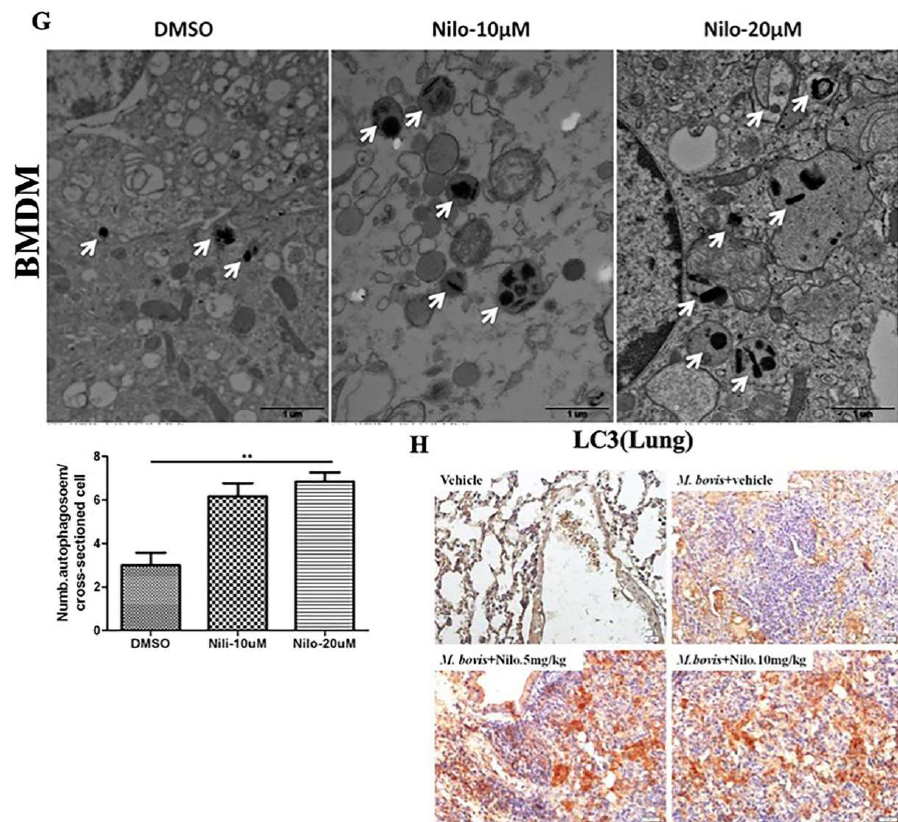
Figure 2. Nilotinib induces autophagy during M. bovis infection. ( A ) and ( B ) BMDM and RAW264.7 cells were pretreated with DMSO (0.1%) or nilotinib 10 µM and 20 µM, followed by M. bovis infection (MOI 1:10) for indicated time. The expression levels of LC3, P62, and LAMP-1 were normalized to GAPDH after treatment for the indicated times. ( C ) BMDM cells were treated with ripamycin (5 µM) and nilotinib (10 µM) alone and in combination with ripamycin before infection with M. bovis . ( D